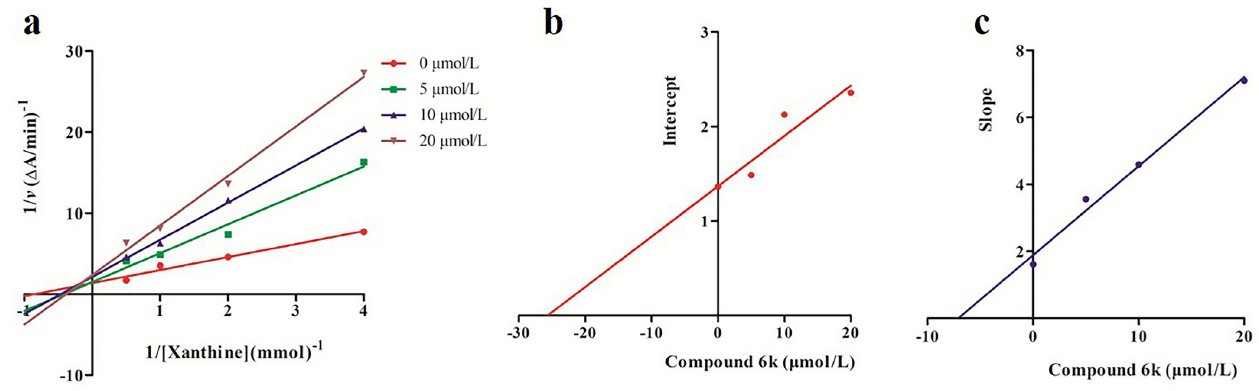
Fig 1. Kinetic analysis of compound 6k inhibited of XO activity. (a) Lineweaver-Burk plots analysis, c(XO) = 55 U/L, c(compound 6k ) = 0, 5, 10, and 20 μ mol/L, c(xanthine) = 0.25, 0.5, 1.0, and 2.0 mmol/L. (b/c) Ki and Kis of compound 6k , Ki and Kis were obtained from secondary plots of the slopes of the Lineweaver-Burk plots and the apparent 1/Vmax versus the inhibitor concentrations, respectively.